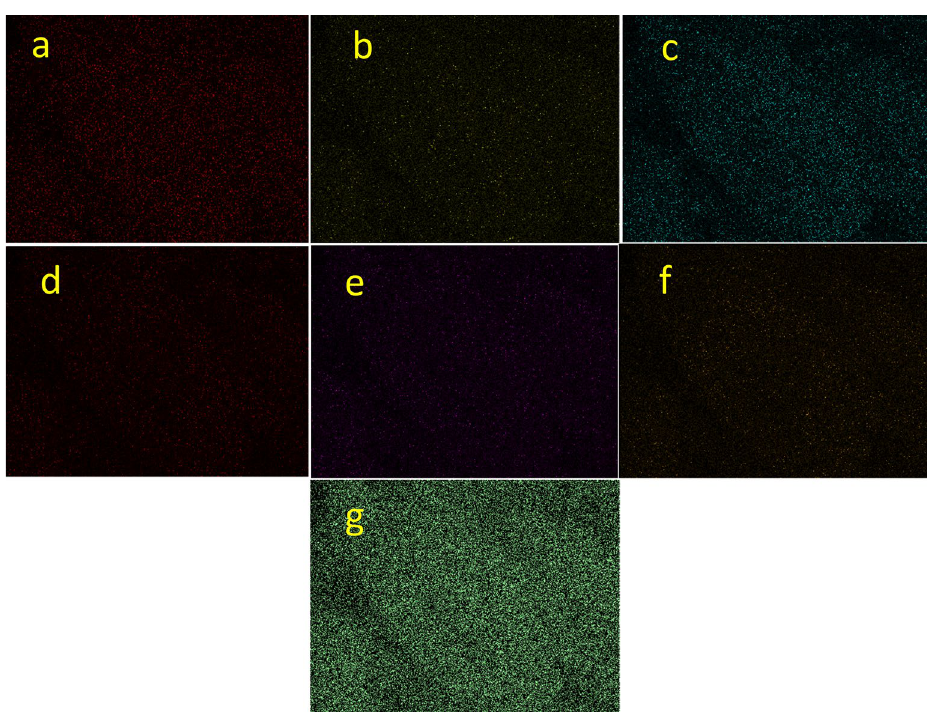
Figure 18. Elemental mapping of ( a ) Al, ( b ) Si, ( c ) O, ( d ) C, ( e ) S, ( f ) N and ( g ) Sm for recovered